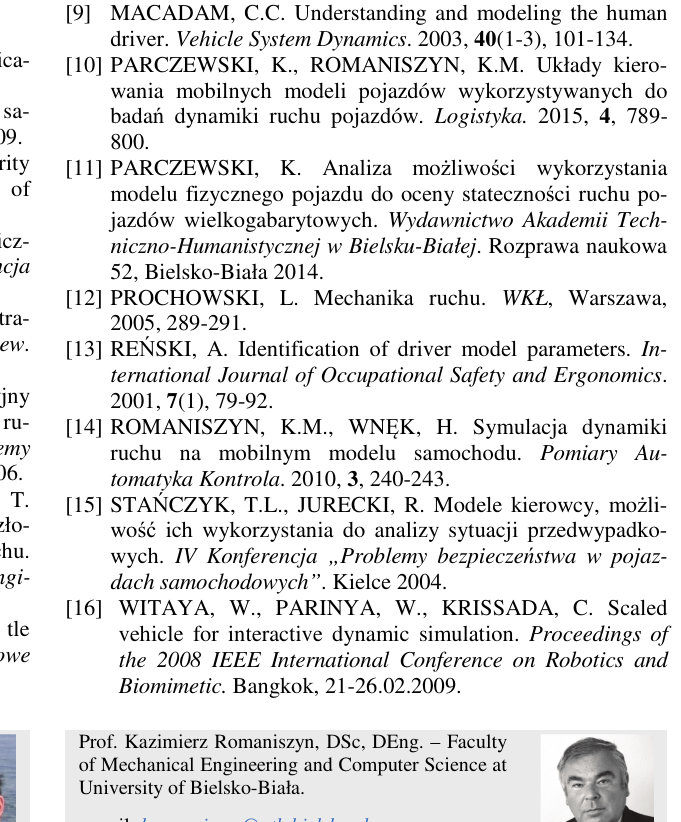
The control system based on the position signals from the GPS, which uses a compensation driver model turned out to be little accurate, due to the low frequency determin- ing vehicle position and relatively slow actuators. However, the use of the more efficient measuring apparatus may al- low to increase the accuracy of control of the vehicle and eventually to apply it to the autonomous vehicle. The use of anticipatory model of human driver allows you to make adjustments to the track of the vehicle. From the simulations carried out using the results of measure- ments made while driving in a circular path indicates that the majority of motion parameters of the vehicle requires filtering with low-pass filter frequency to 6 Hz. The appli- cation of the proposed solution requires the use of actuators with a short response time. Delays resulting from the reac- tion speed of actuators require estimating and taking into account in the applicable adjustment of control parameters. Ultimately, the planned modifications to the vehicle in scale by incorporating a system of speed control and steer angle with greater accuracy and speed of execution. Despite this, the authors believe that the results of both of the tests are promising and believe that further research in this area is Fig. 7. The vehicle path: real (from the test) and corrected, during the test “ride on a circular path”